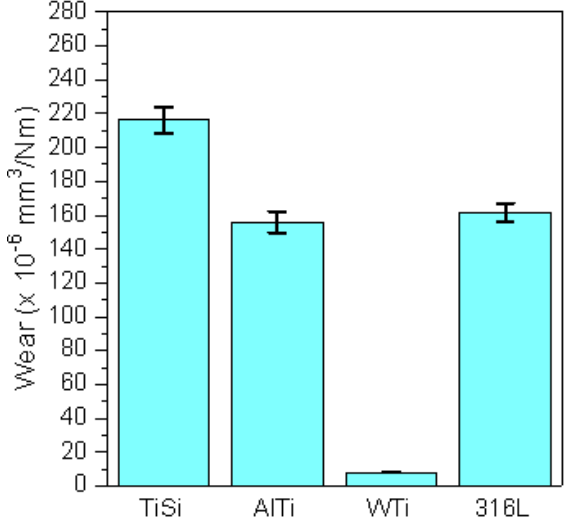
Figure 8. Wear rates of the TiSi, AlTi, WTi coatings, and the 316L stainless steel substrate.